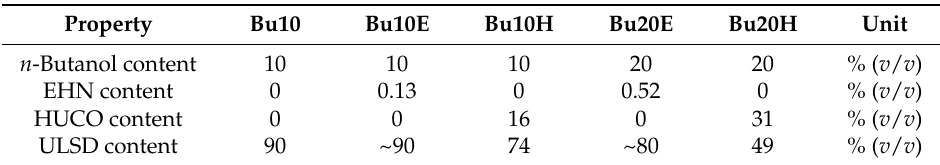
Table 6. Detailed composition of created blends.